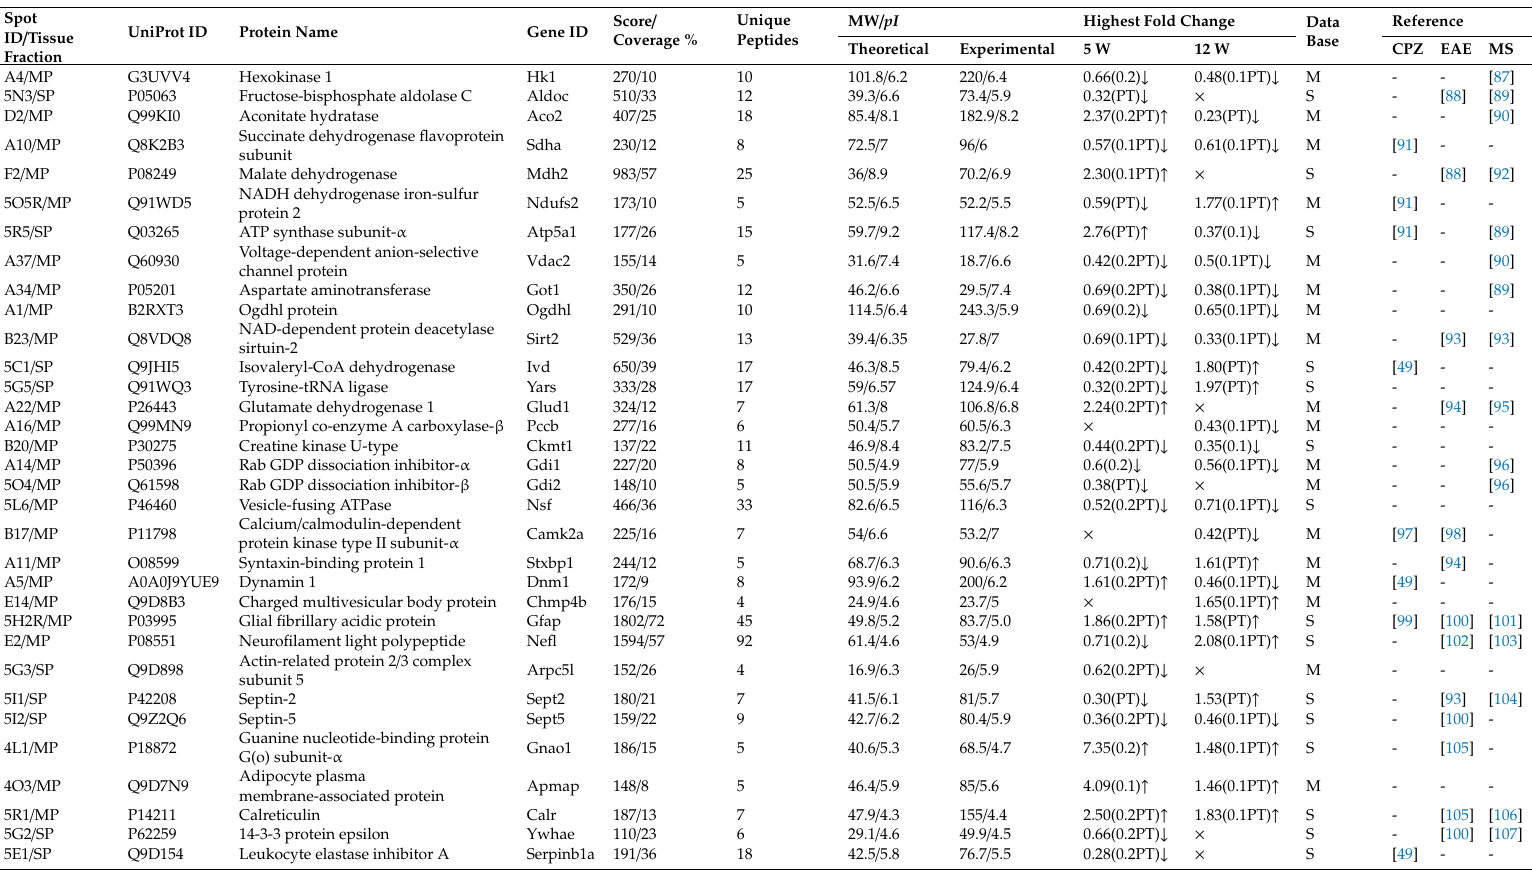
Table 1. 2DE LC / MS / MS analyses identified 33 proteins from 5- and 12-week studies.